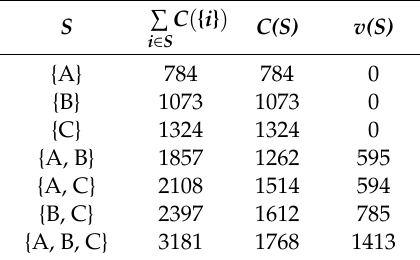
Table 1. An example of three carriers.